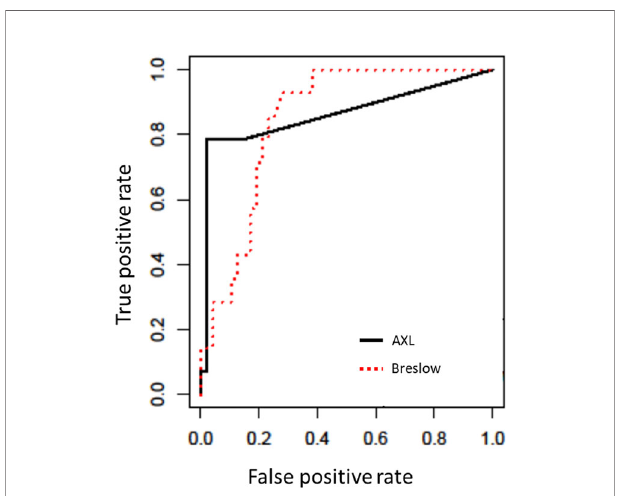
FIGURE 3 | Receiver-operating characteristic (ROC) curves obtained for AXL and Breslow index. Area under the curve was 0.86 for AXL and 0.85 for Breslow index.